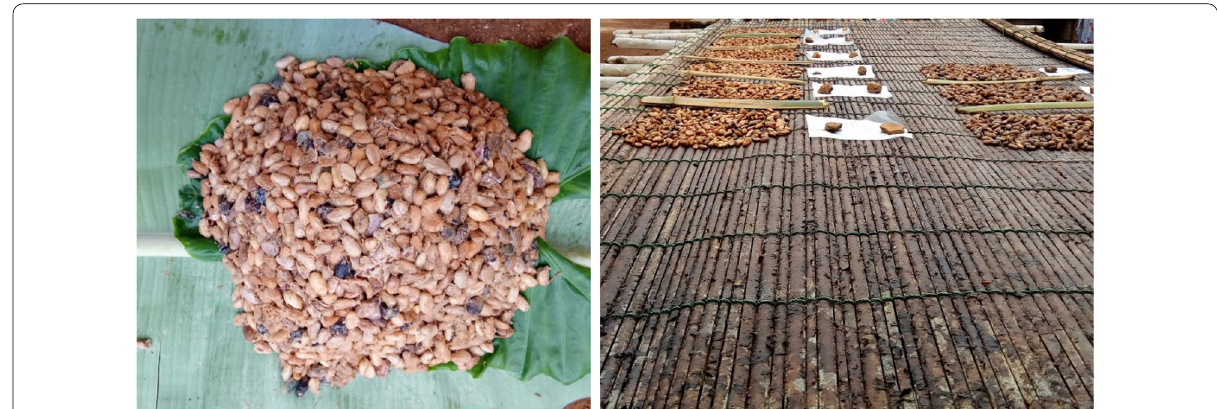
Fig. 1 Fermentation and drying of sampled cocoa beans with traditional leaf heap method and sun drying